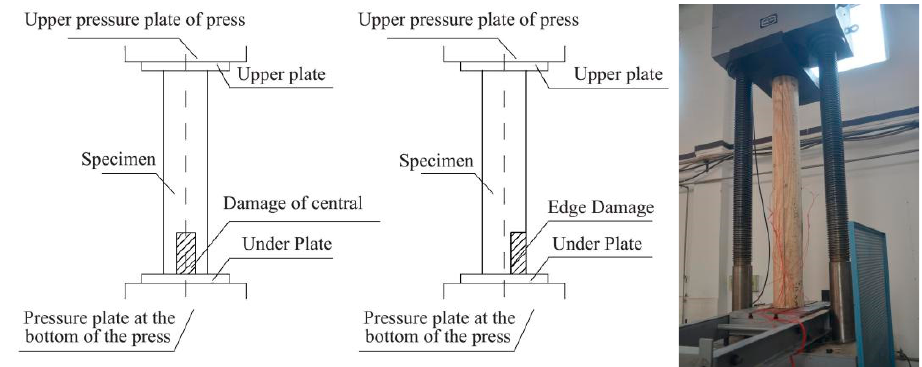
Figure 11. Scaled specimens test.